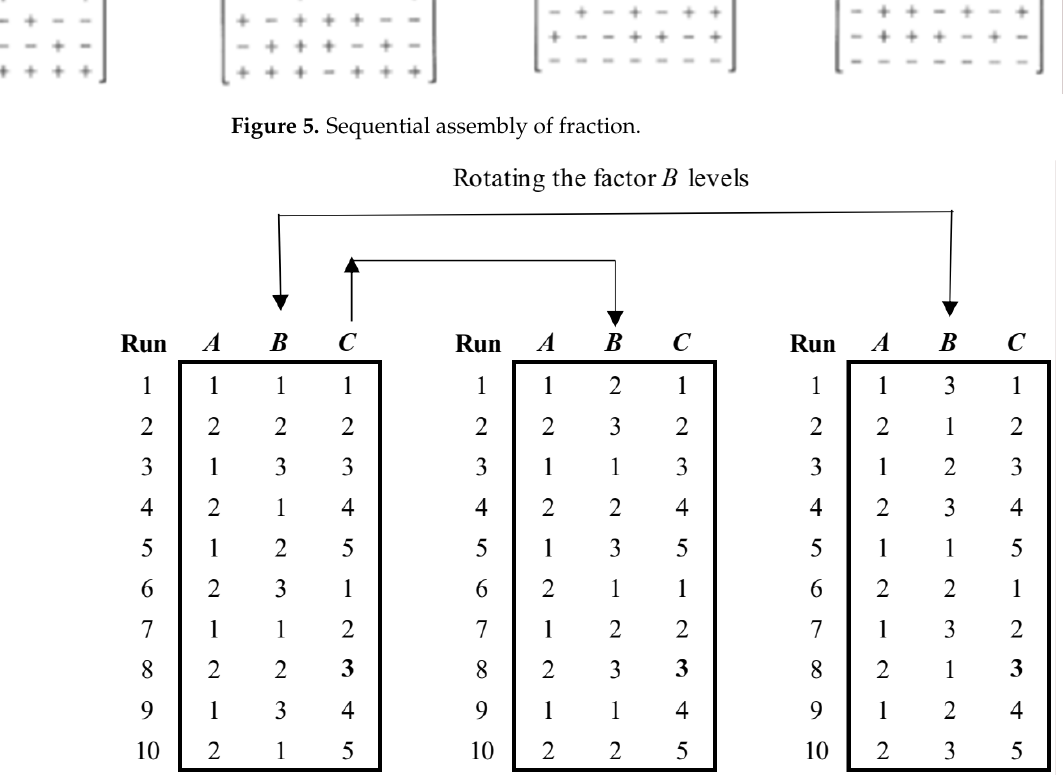
Figure 6. Level rotation for factor B of NONBPA (2 1 3 1 5 1